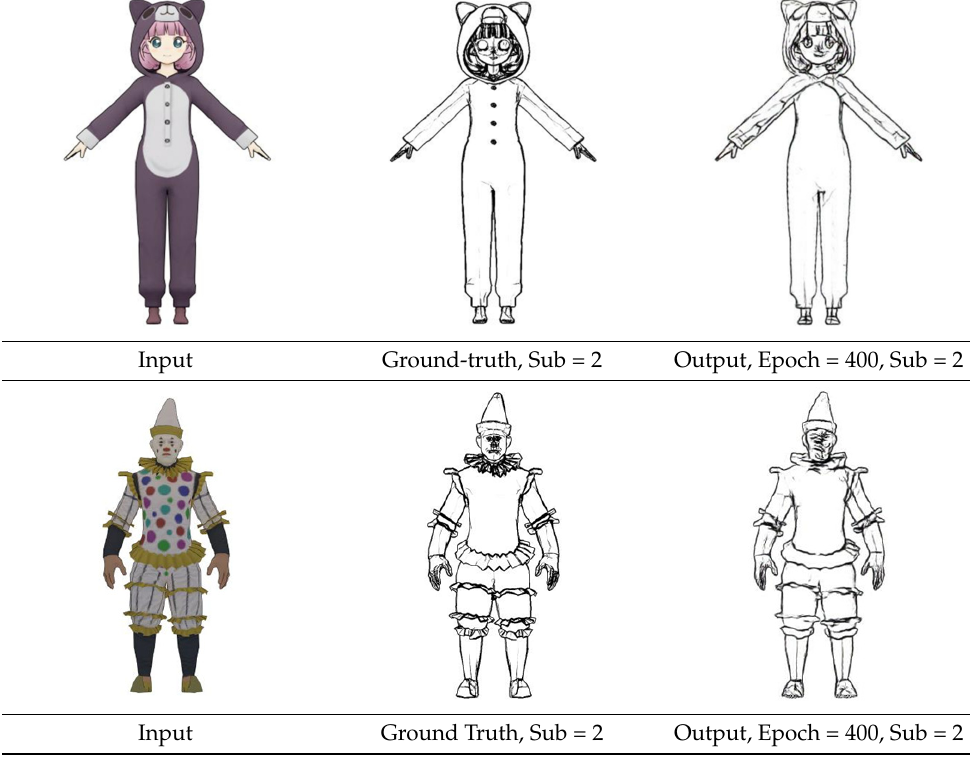
Table 6. Result of the line drawing extraction using a conditional GAN (Example 4).